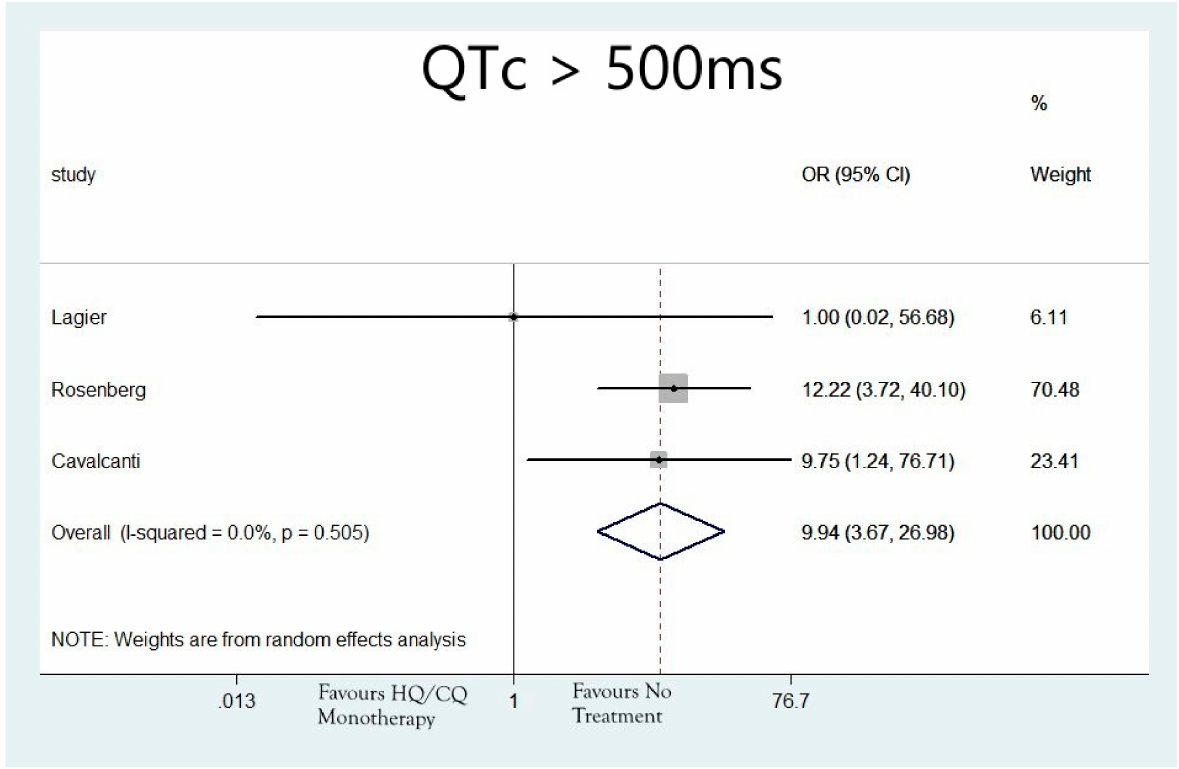
Figure 3. Risk of developing QTc > 500 ms in patients that received hydroxychloroquine